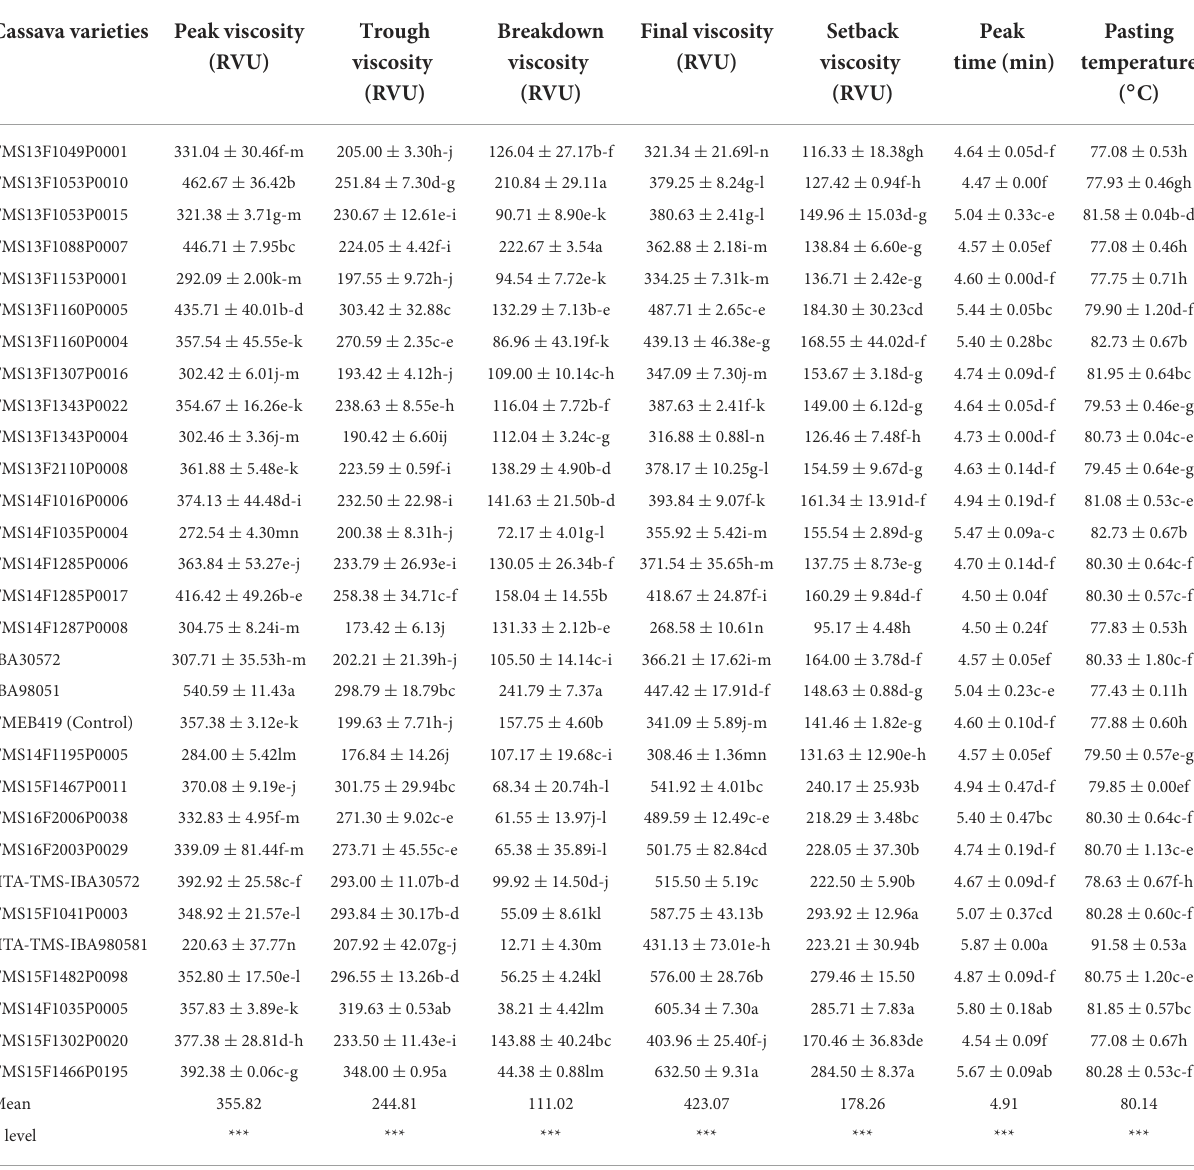
TABLE 3 Pasting properties of gari produced from the cassava genotypes and the control variety. Cassava